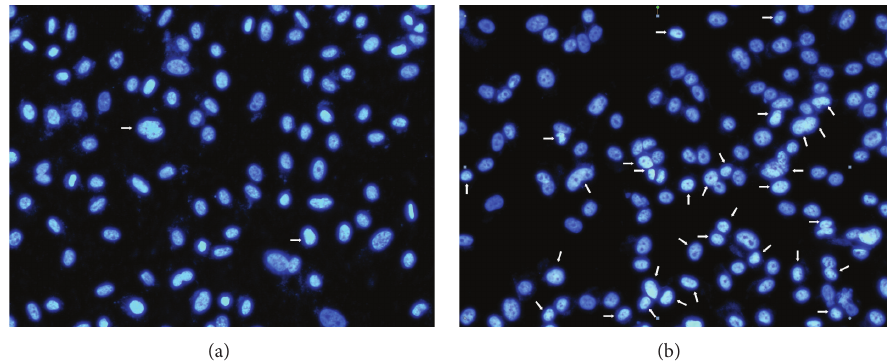
Figure 5: Morphological changes in the nuclei of PC 3 cells. (a) PC 3 control: the majority of cells had uniformly stained nuclei after staining with Hoechst. (b) PC 3 cells after 24 h exposure to 29 𝜇 M isofuranodiene induced morphological changes typical of